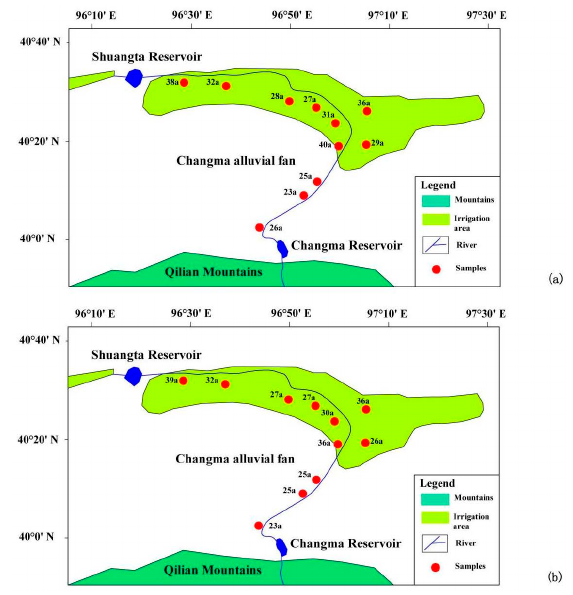
Figure 6. Groundwater age distribution of shallow groundwater in the Changma alluvial fan, ( a ) 18 July 2013; ( b ) 16 October 2013.